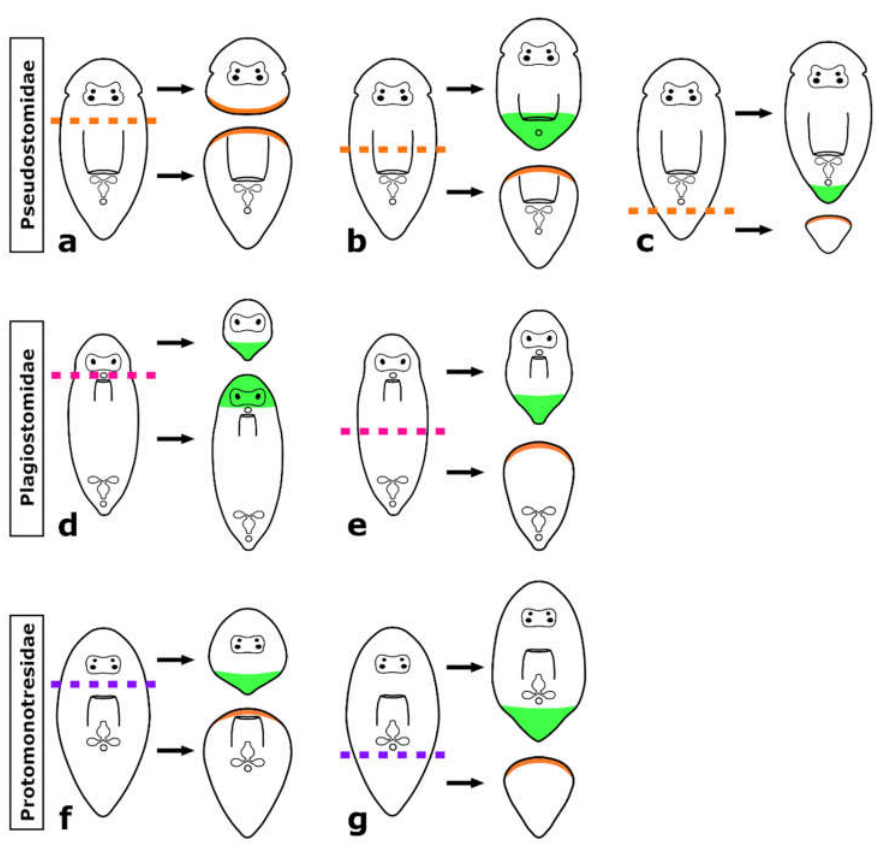
Figure 15. Regeneration capacity in Prolecithophora. Summary of the best known regeneration capacity in Pseudostomidae ( a – c ), Plagiostomidae ( d , e ) and Protomonotresidae ( f , g ) after amputation between brain and pharynx ( a , d , f ), through the pharynx ( b ) and posterior to the pharynx ( c , e , g ). Green highlights in the schematics show regenerated tissues while orange highlights indicate only wound healing.